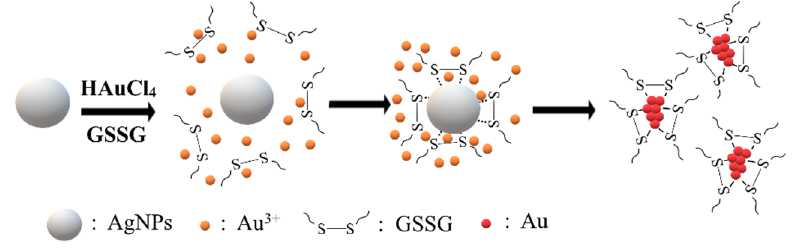
Figure 7. Ag NPs serve as a platform to synthesize thiolated Au NCs. Supplementary Materials: The following are available online at https://www.mdpi.com/article/10.3 390/nano11112835/s1, Figure S1: The setups for violet LED irradiation to generate quasi-spherical Ag NPs. The LED lamps were turned off (left), and on (right). Figure S2: Emission scan of samples from solutions for synthesis of Au NCs in the presence (green line), and absence (red line), of Ag NPs. The excitation wavelength was set at 370 nm. Figure S3: Time-dependent UV-Visible spectroscopy of solution after Ag NPs were mixed with HAuCl 4 . Figure S4: TEM images of spherical-like Ag NPs after they were mixed with